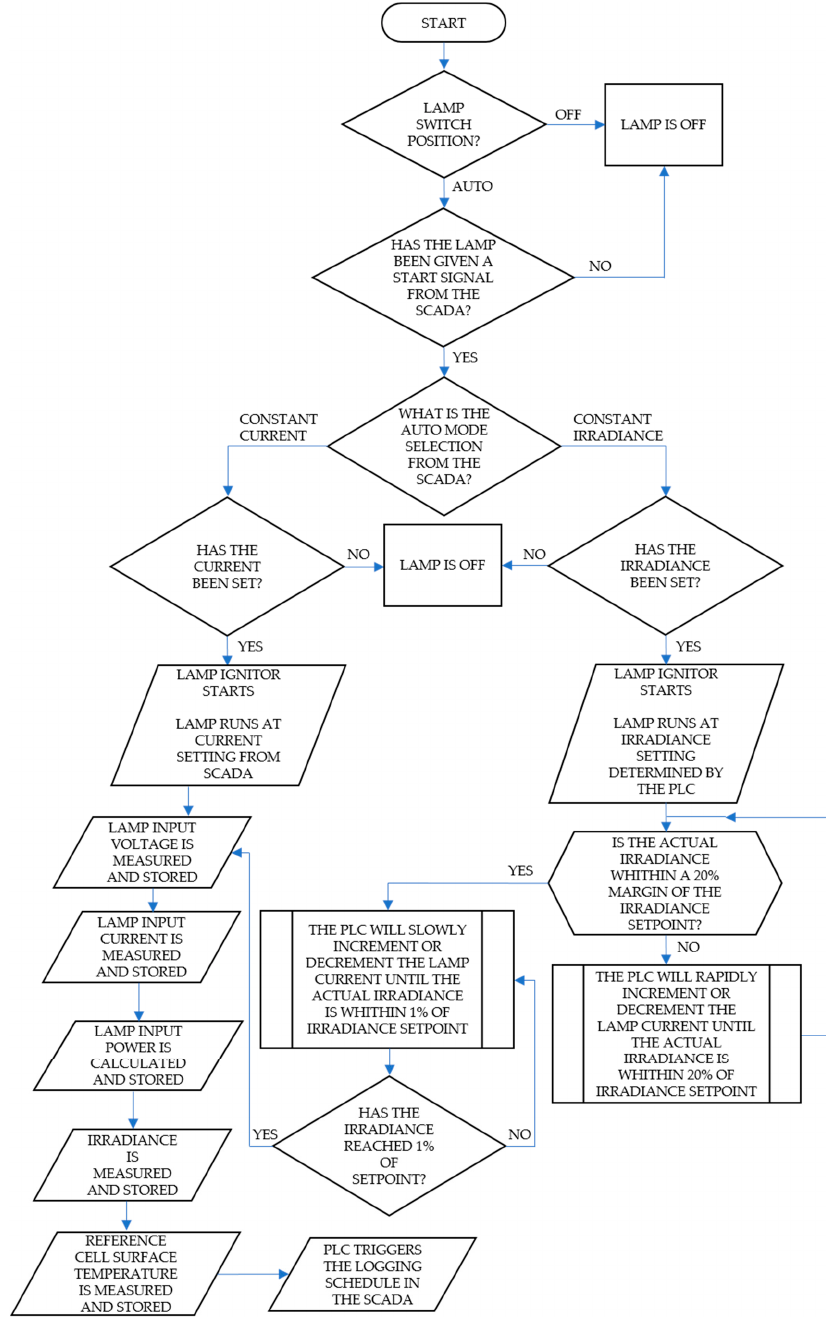
Figure 6. Algorithm for the Xenon arc lamp solar simulator autonomous dynamic adaptability system (ADAS).